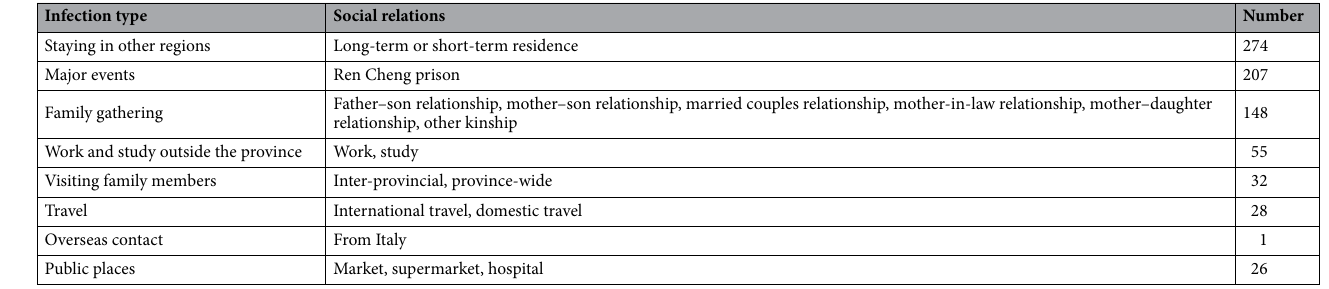
Table 1. Infection type and social relations of confirmed COVID-19 cases in Shandong province. Close contact refers to infection without clear social